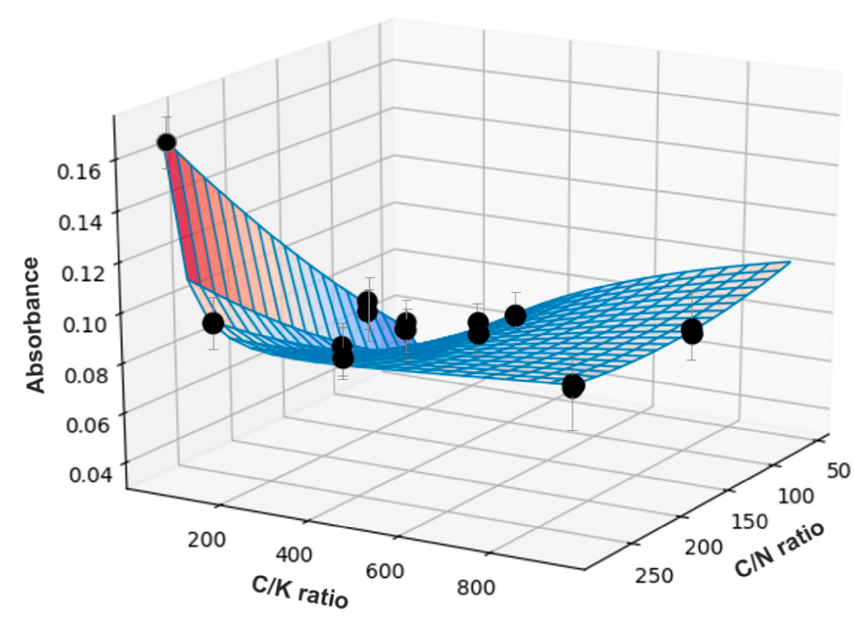
Figure 6. Response surface of the mathematical model of absorbance as a function of the C/N and C/K ratio, back view.